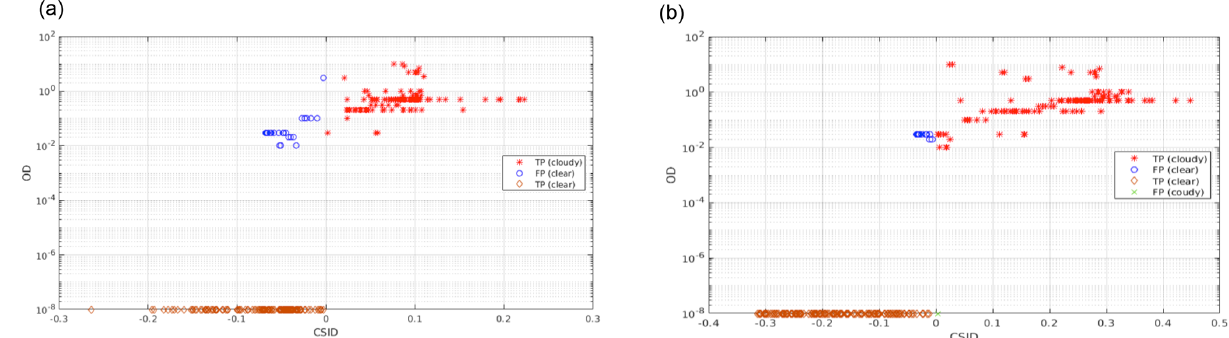
Figure 12. Classification of the tropical test set as a function of the optical depth of the elements (a value of 10 − 8 is used to plot the clear-sky cases). Data are plotted as a function of the corrected similarity index difference (CSID) and cloud optical depth (OD). (a) CIC run using 128 MIR channels. (b) CIC run using the 128 MIR and 129 FIR channels. For both cases the distributional approach is assumed. Colour codes are reported in the legend.